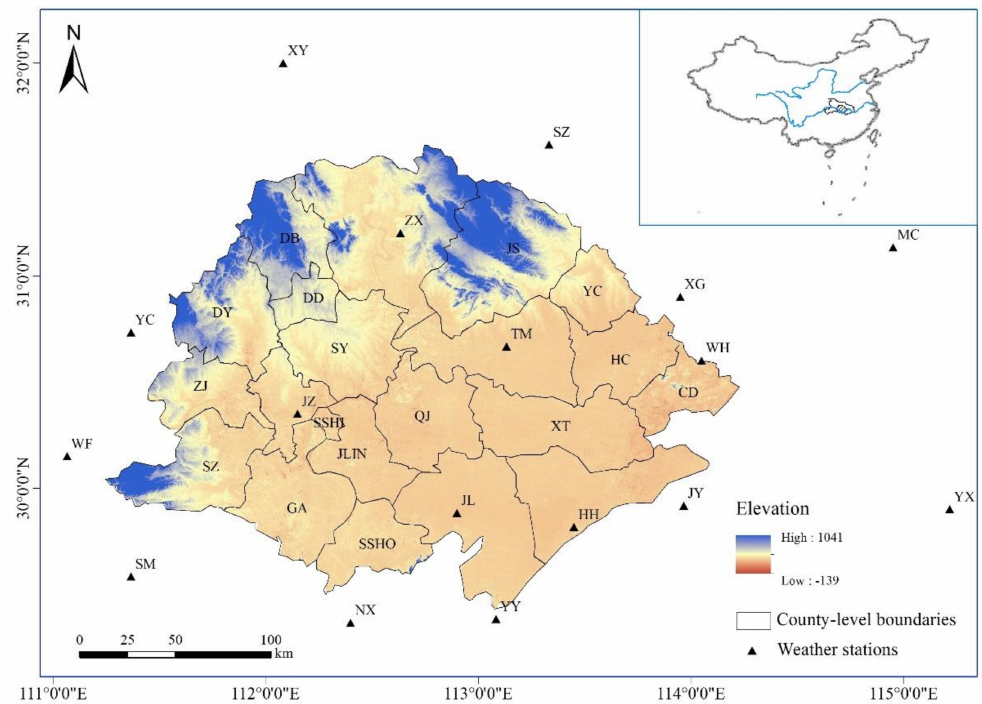
Figure 1. Topography map of the Jianghan